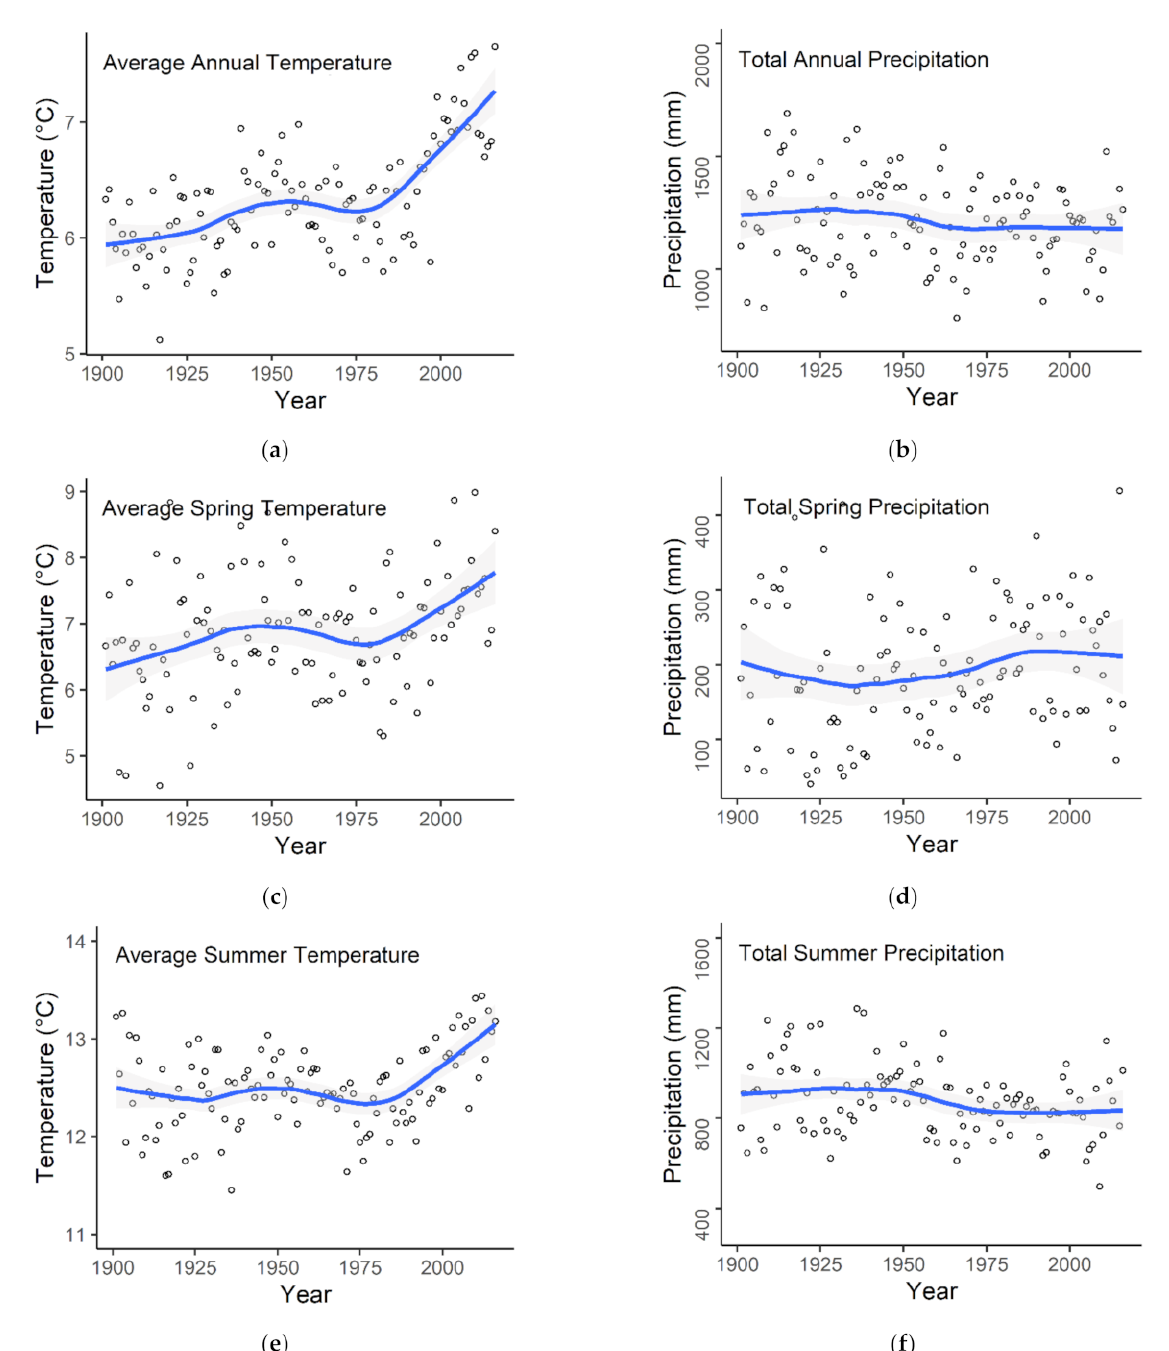
Figure 3. Growing season (spring (March, April, May) and summer (June, July, August, September) and annual mean temperature and total precipitation trends based on the CRU TS 4.04 grid average data. ( a ) Average annual temperature, ( c ) Average spring temperature, ( e ) Average summer temperature, ( b ) Total annual precipitation, ( d ) Total spring precipitation and ( f ) Total summer precipitation. The blue lines are the LOWESS smoothing (locally weighted scatterplot smoothing) with 50% span, gray shades are 95% confidence